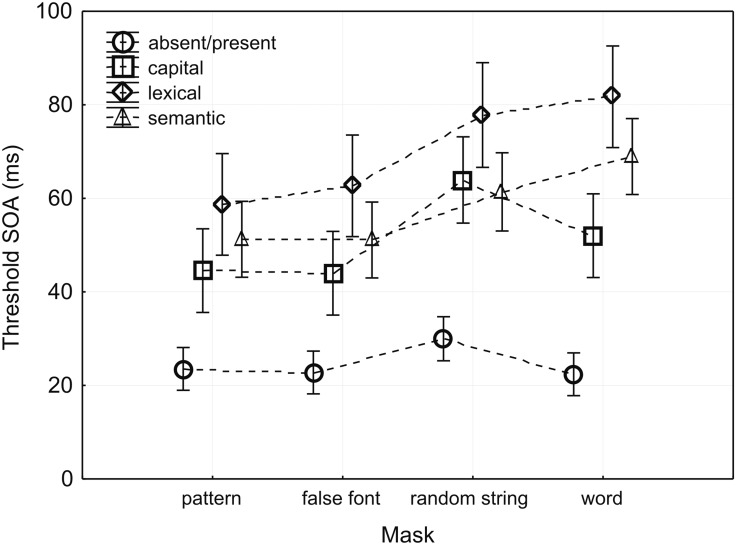
Thresholds for each task (SOA in ms) in each of the four mask groups. Depicted are mean values and the ±95% confidence interval. Please notice that dotted lines connecting the given task over the four different masks connect results from the four different groups.